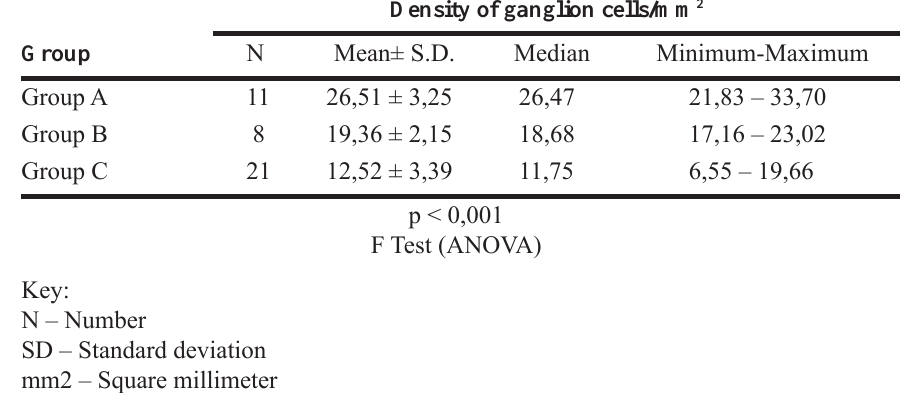
TABLE 3 - Multiple comparisons among Groups A, B and C, for the variable “Density of ganglion cells” Variable